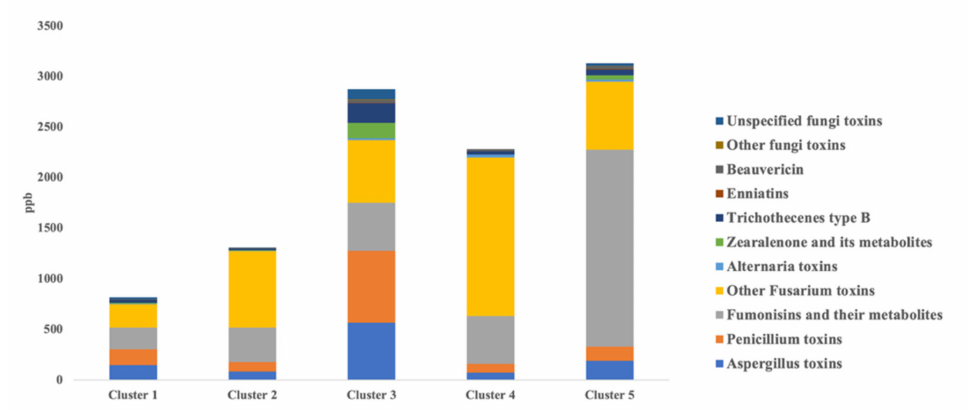
Figure 1. Cumulative values (expressed as µ g/kg dry matter) of the major mycotoxins and their metabolites detected in the corn silages belonging to the different